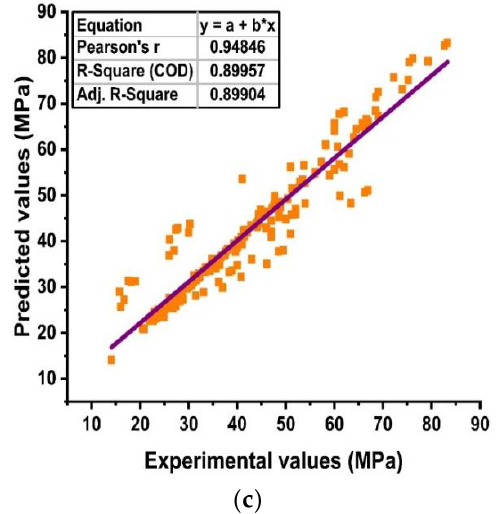
Figure 6. ANFIS ( a ) training, ( b ) validation, ( c ) testing. Figure 7 shows the rules assigned to ANFIS for the optimum outcome.